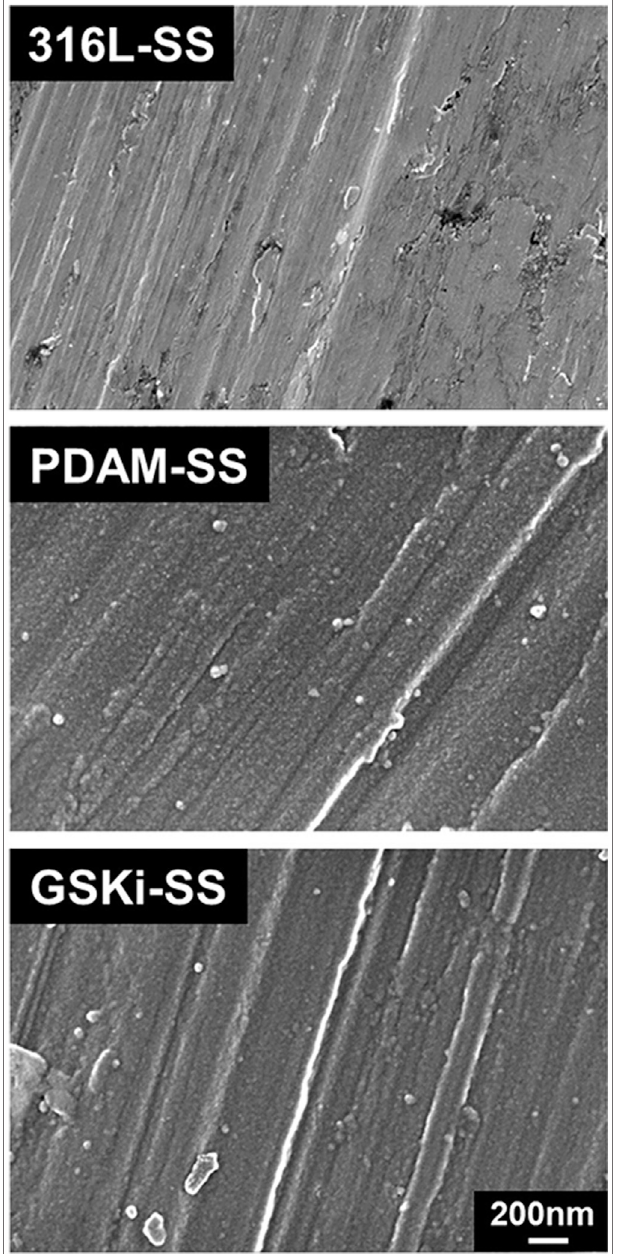
FIGURE 3 | SEM images of 316L-SS, PDAM-SS and GSKi-SS.